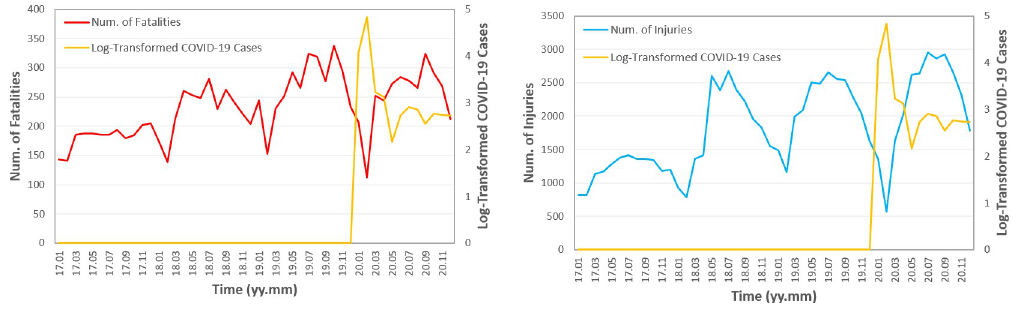
Fig 3. The trend of e-bike safety in China. (a) the number of fatalities. (b) the number of injuries.